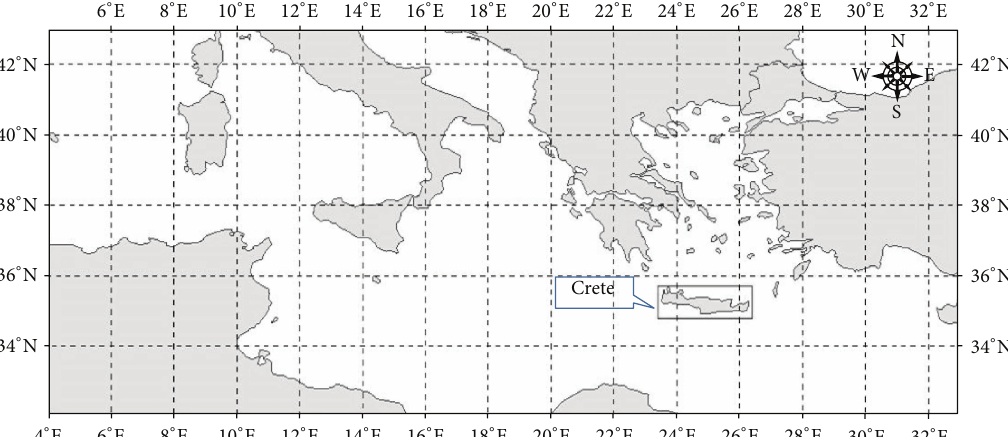
Figure 2: The domain of study including part of middle-eastern Mediterranean. Noted is Crete for which rain events are investigated.